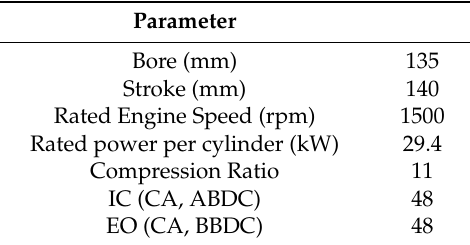
Table 1. Dimensions of original 2135 diesel engine.